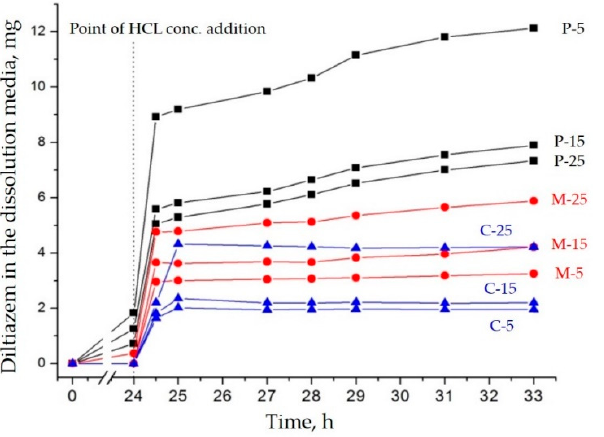
Figure 8. Diltiazem release from physical mixtures (P), solid dispersions (C), and microsponge (M) formulations .